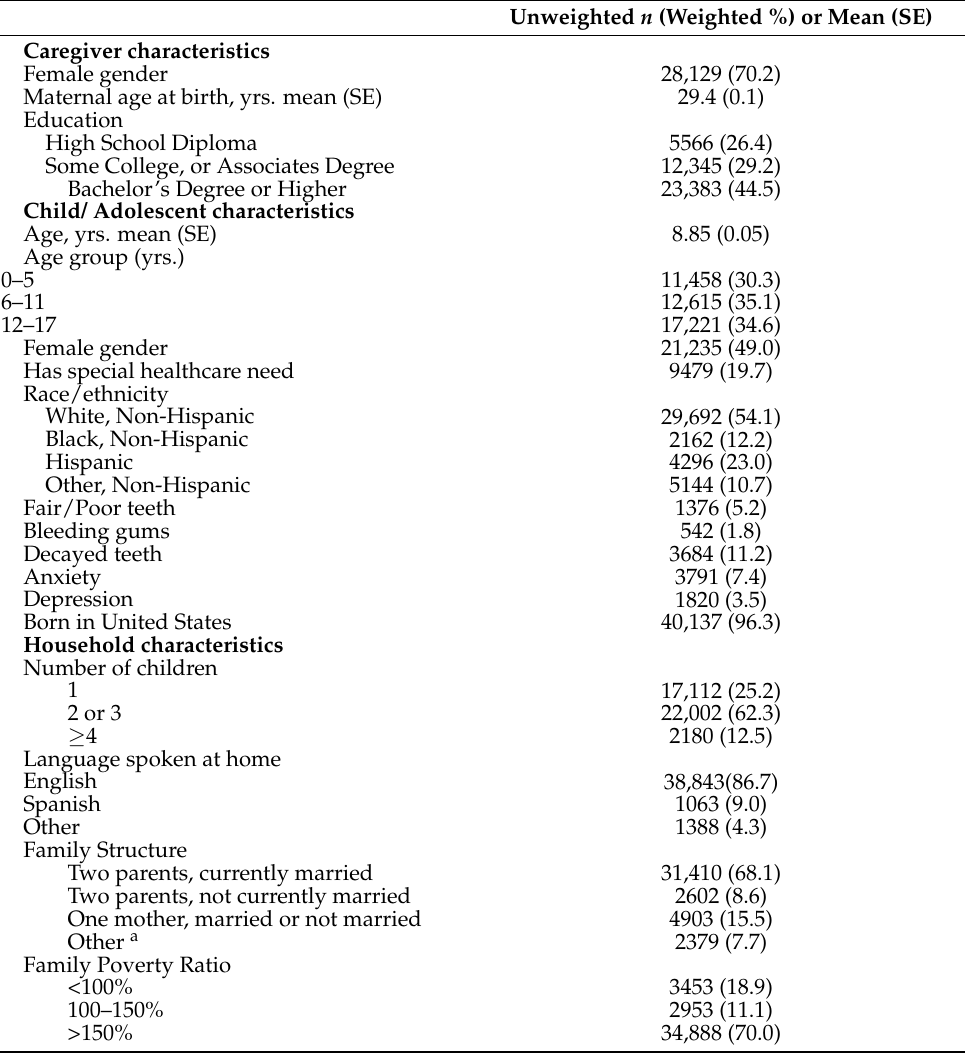
Table 1. Distribution of socio-demographic factors, National Survey of Children’s Health, 2016 ( n =